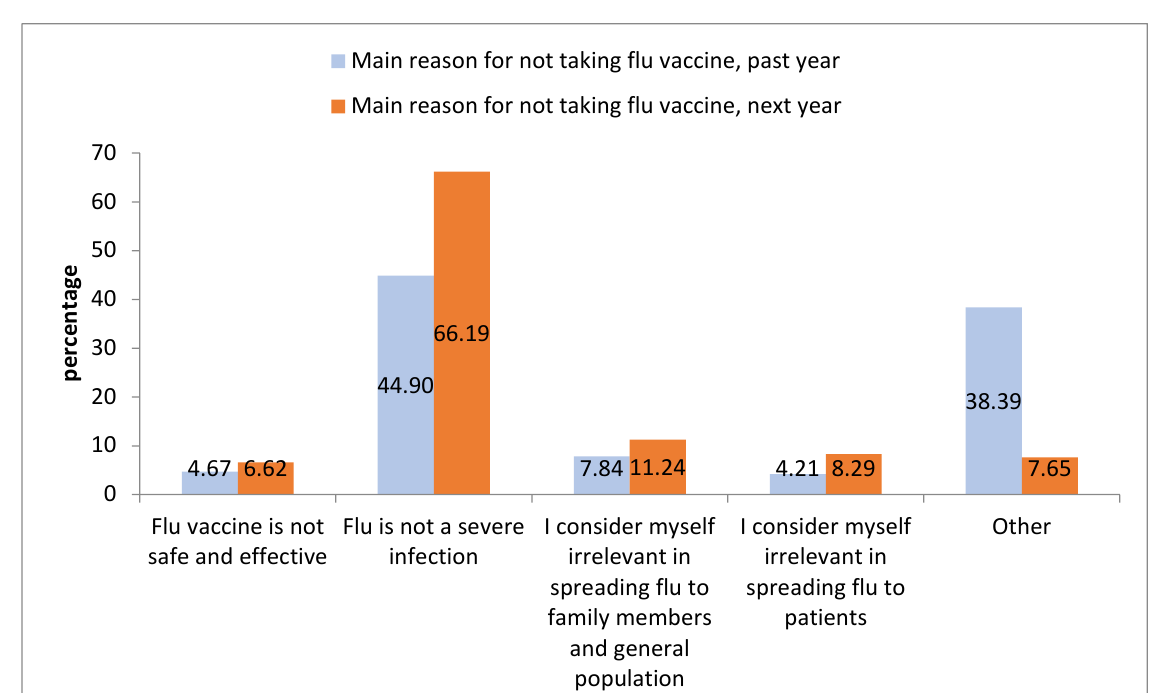
Figure 2. Comparing main reason for not taking infl uenza vaccine the previous/following year. Used Pearson’s chi-squared test, chi-squared p -value < 0.001.